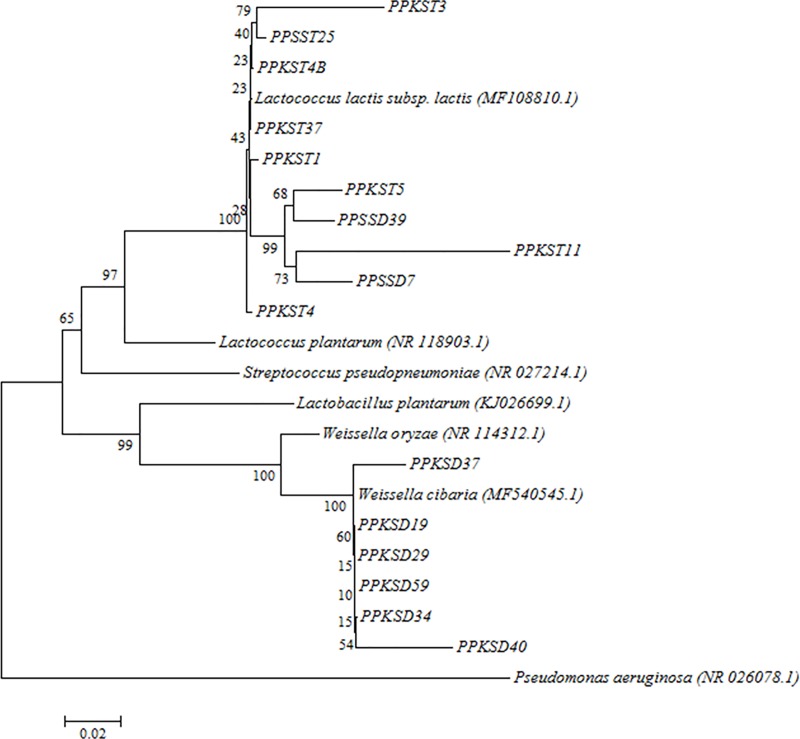
Phylogenetic tree showing the relative position of selected endophytic LAB isolates based on 16S rDNA partial sequences, using the Neighbor-Joining method.Pseudomonas aeruginosa was used as an outgroup. Bootstrap values of 1000 replications are displayed at the nodes of the tree, using MEGA 6. The scale bar corresponds to 0.02 units of the number of base substitutions per site. The GenBank accession numbers for nucleotide sequence data are shown in brackets.